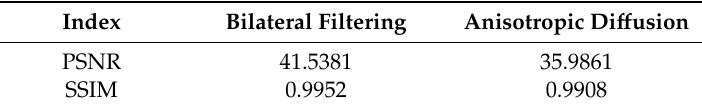
Table 1. An evaluation index for the two filtering